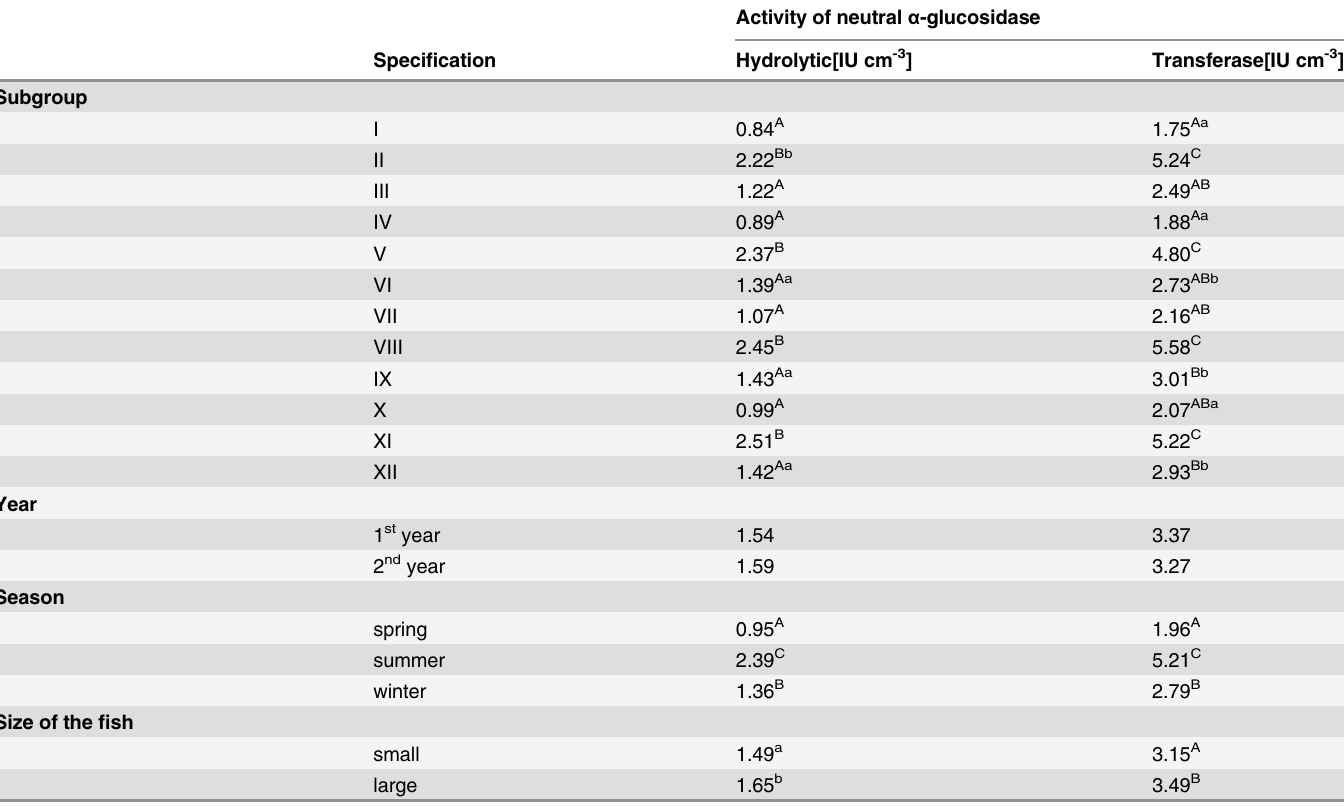
Table 4. Activity of neutral α -glucosidase in experimental subgroups and